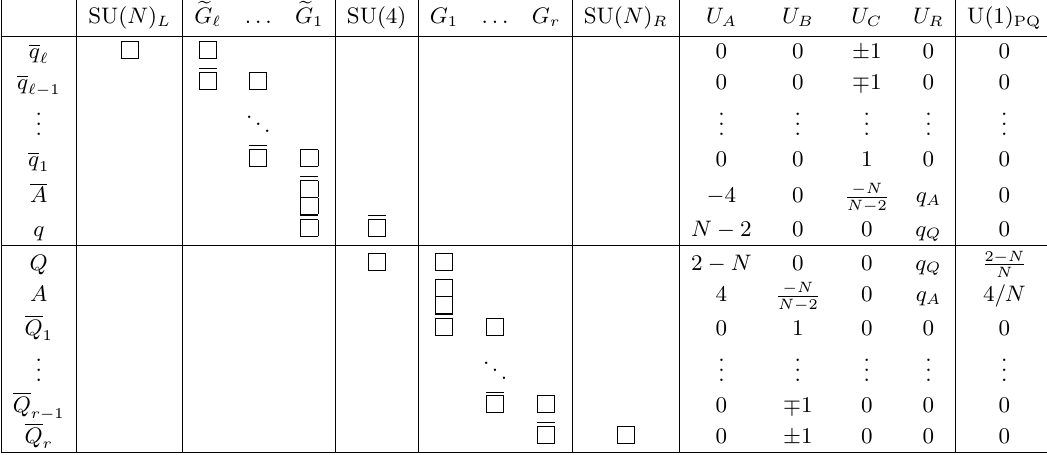
Table 1 . Representations of the matter (cid:12)elds under the gauged SU( N ) ‘ tries, the (cid:13)avor symmetries SU( N ) L